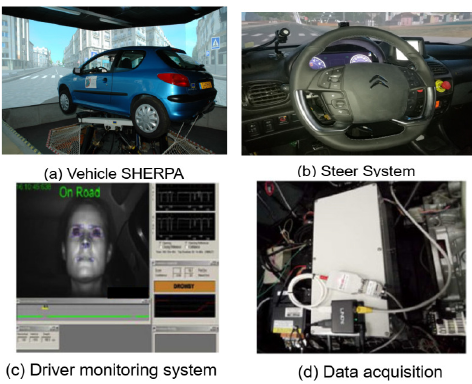
Figure 7. Experimental setup for the SHEPRA vehicle